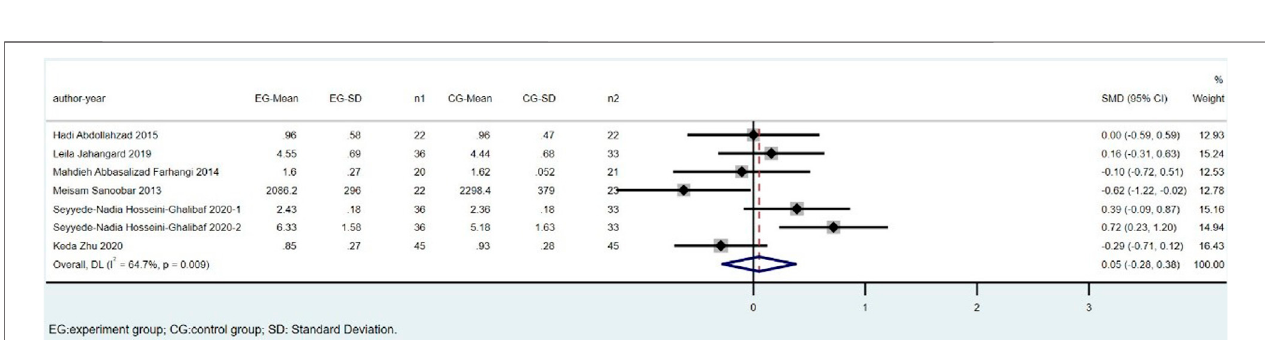
FIGURE 5 | Meta-analysis of studies investigating the effect of CoQ10 supplements use on TAC level.